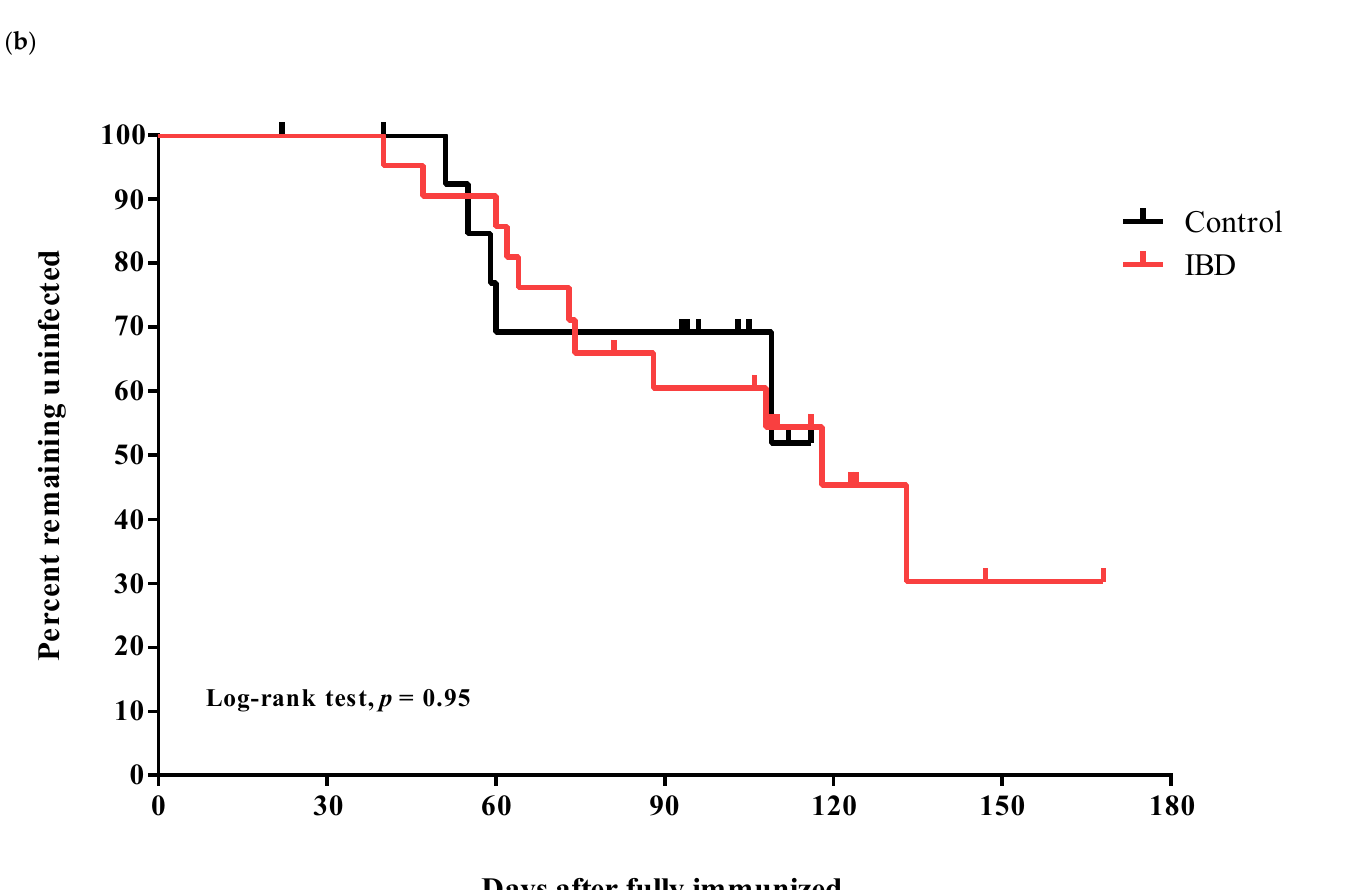
Figure 2. Breakthrough infection during the investigational period. ( a ) Number of confirmed coronavirus disease 2019 cases and dominant variants in Korea and our study population. The blue line indicates total cases, and the orange line indicates the number of adolescent cases (10–19 years of age) in the Korean population. Dark blue dots indicate the date of the second dose of immunization for the control group, and red dots indicate the IBD group in our study. Short vertical lines show the median date of the second immunization in each group. ( b ) Kaplan–Meier curves for the infection-free survival from breakthrough infections in the two groups during the investigation period coincided with those during the Omicron outbreak.